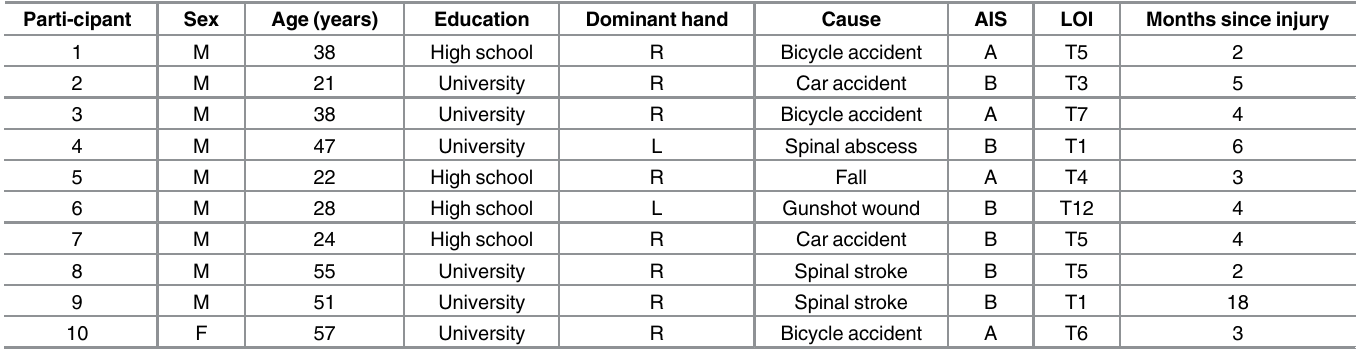
Abbreviations: AIS, American Spinal Injury Association Impairment Scale [22]; LOI, level of injury as assessed by the International Standards for Neurological Classi fi cation of Spinal Cord Injury (ISNCSCI); SCI, spinal cord injury. High school = graduated from high school; University = undergraduate degree at